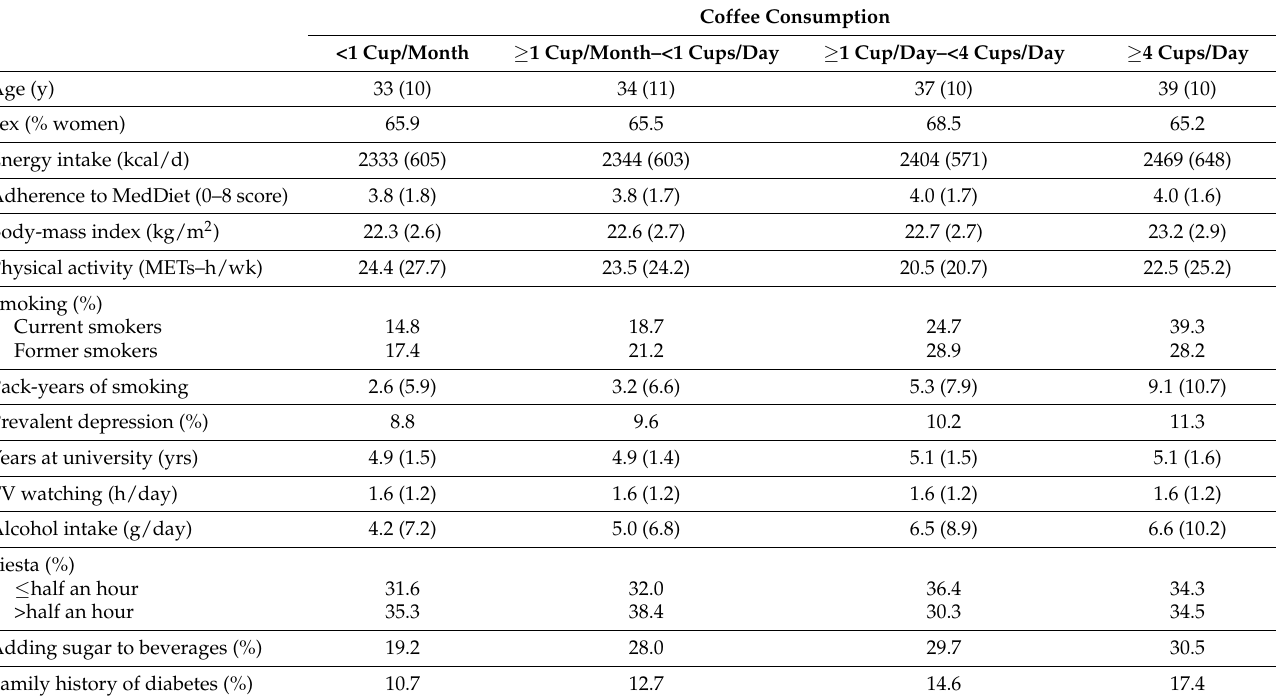
Table 1. Baseline characteristics of the SUN Participants according to baseline total coffee